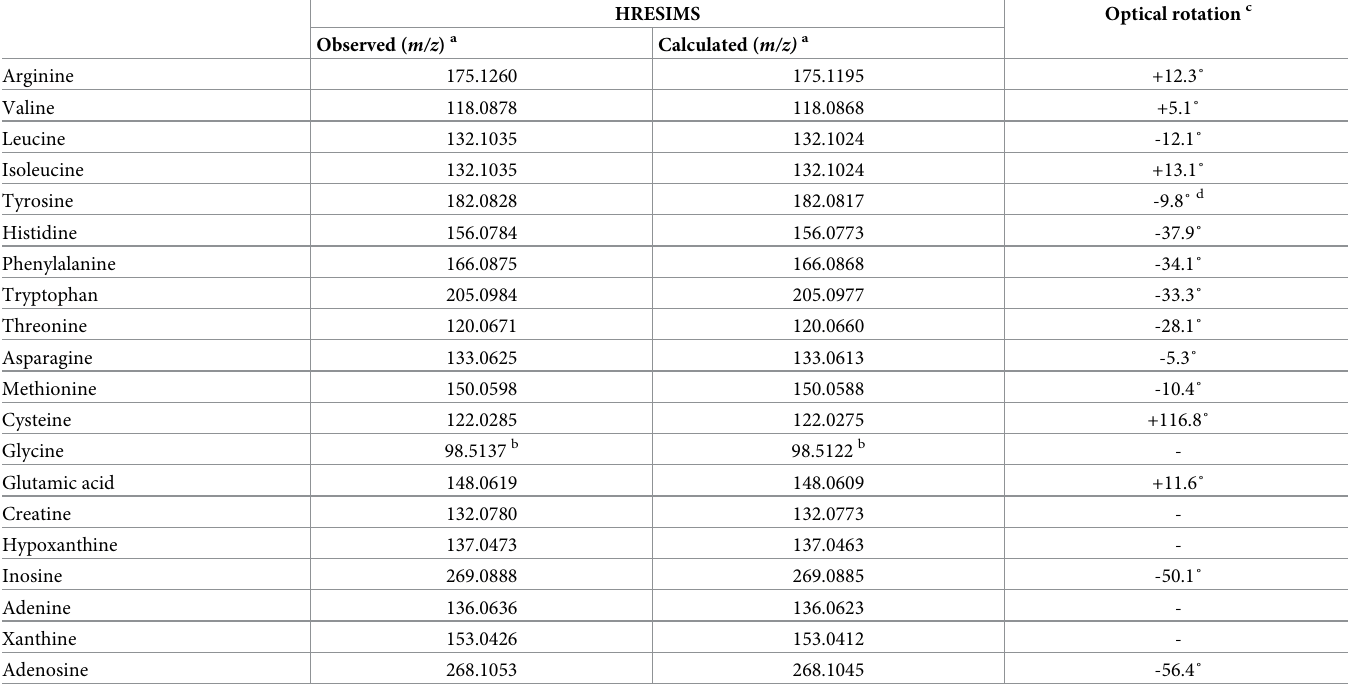
Table 3. HRESIMS and optical rotation data of amino acids and nitrogenous